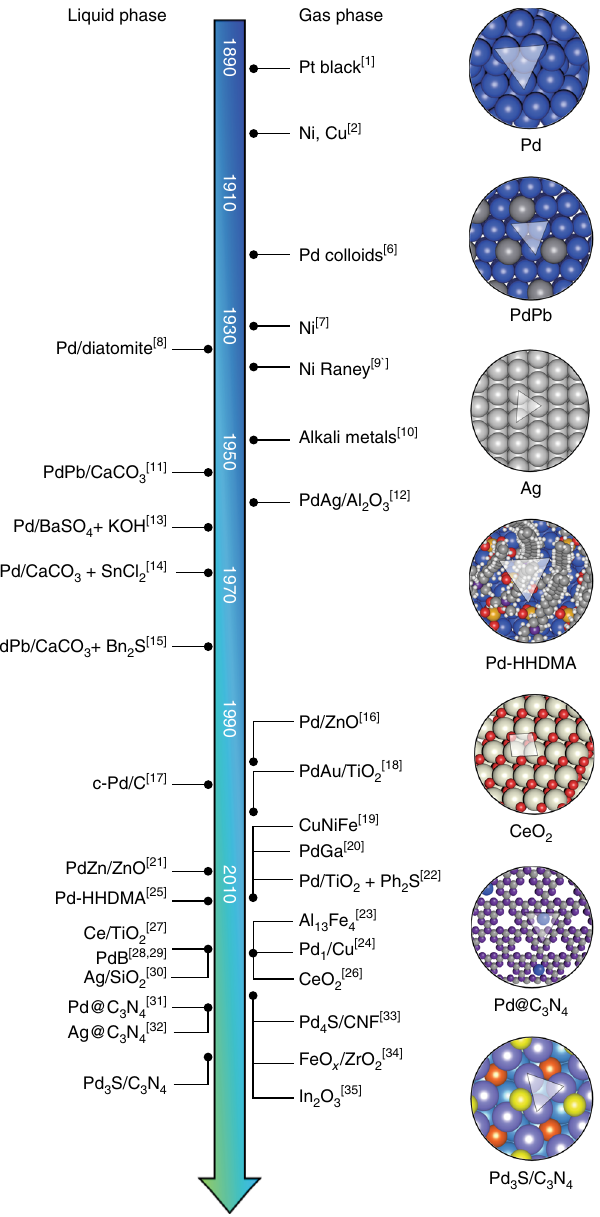
Fig. 1 Survey of alkyne semi-hydrogenation catalysts. Chronological development for gas- and liquid-phase applications tracing from